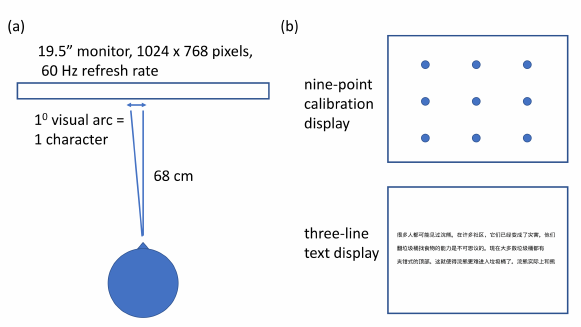
Figure 3. (a) A schematic representation of the experimental setup. Participants sat approximately 68 cm from the display 19.5” display. Characters subtended one degree from visual arc; (b) At the start of each reading session participants’ eye movements were calibrated using nine-point grid. Following satisfactory calibration, participants read text three lines at a